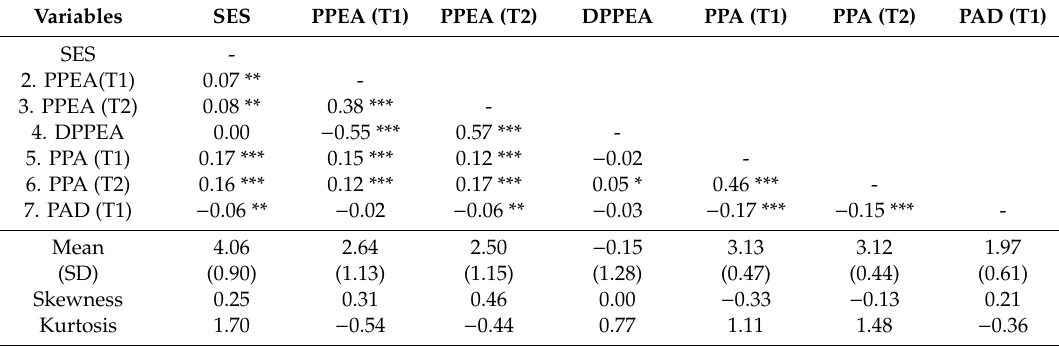
Table 5. Correlation and statistical analyses of observed variables for Cohort